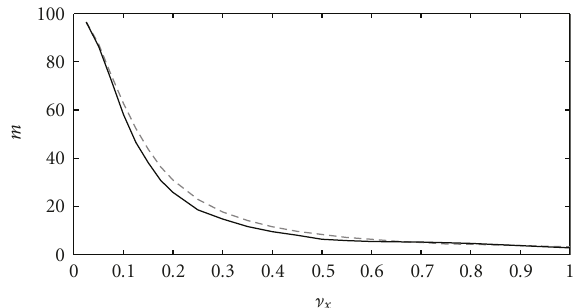
Figure 3: Number of sensor nodes selected by the greedy (solid) and the on-the-fly (dashed) algorithms as a function of the coherence